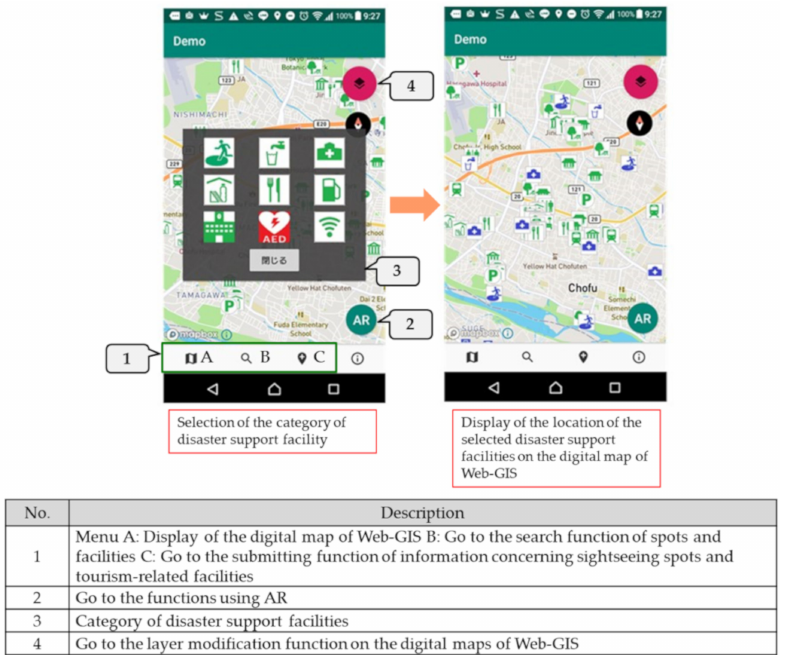
Figure 7. Screen for the layer modification function of the digital maps of